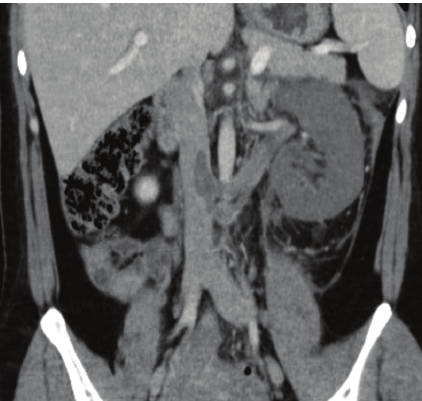
Figure 1: Swelled and nonfunctional left kidney and a thrombus including left renal vein and inferior vena cava.